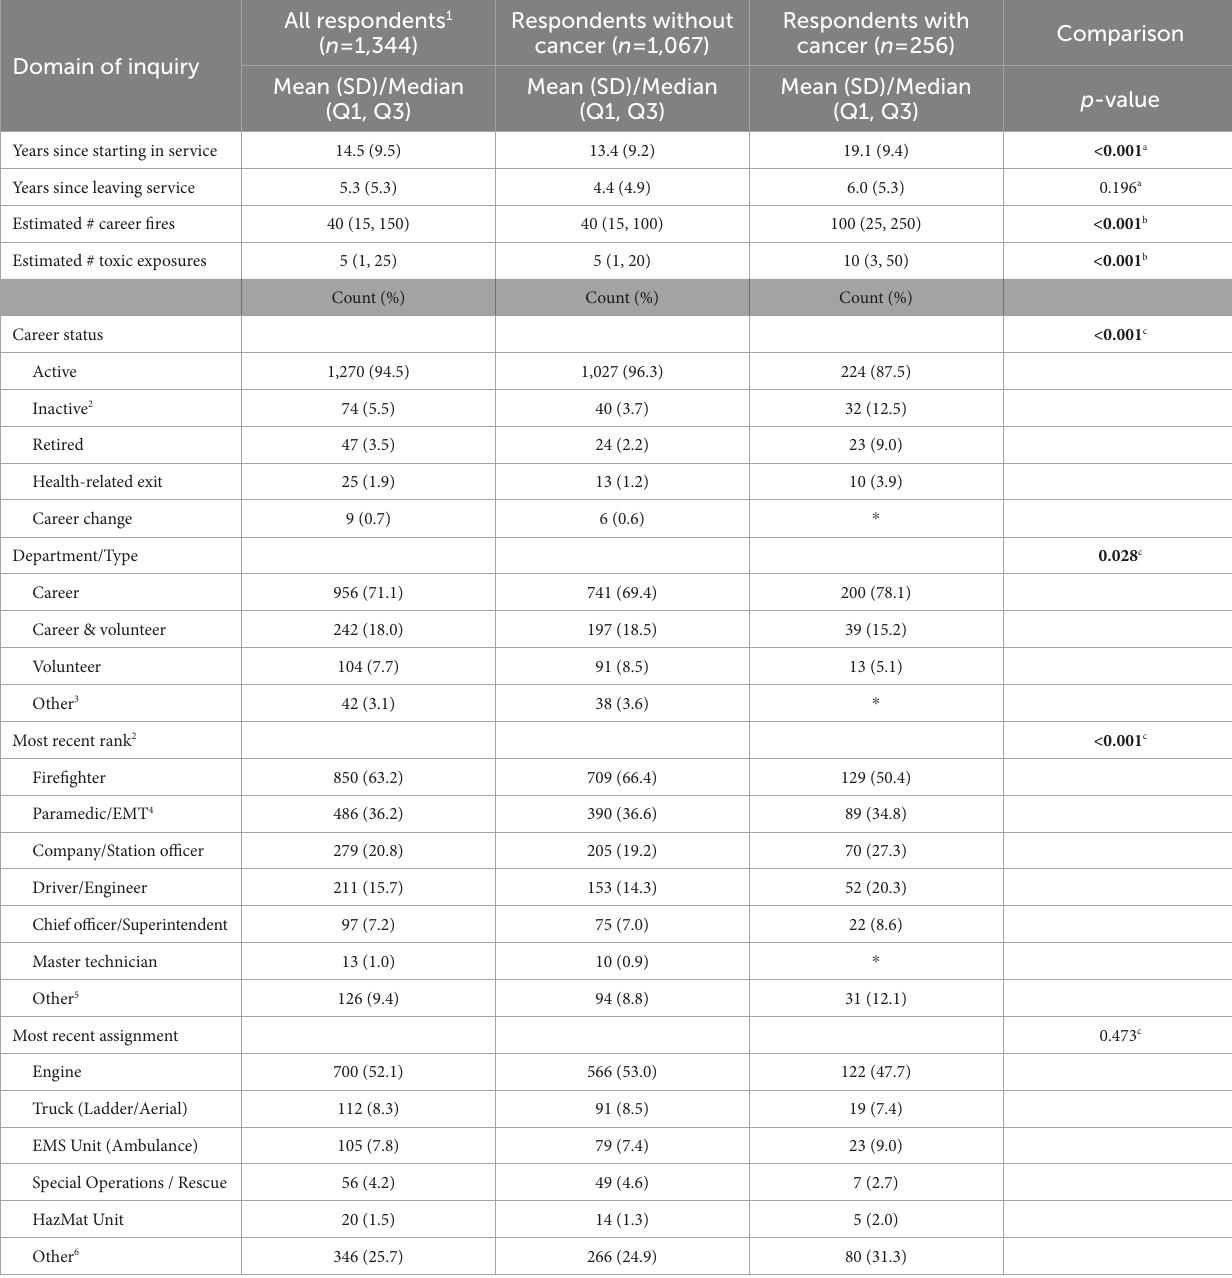
TABLE 2 Firefighting experience and exposure history of female firefighter survey respondents, by presence and absence of